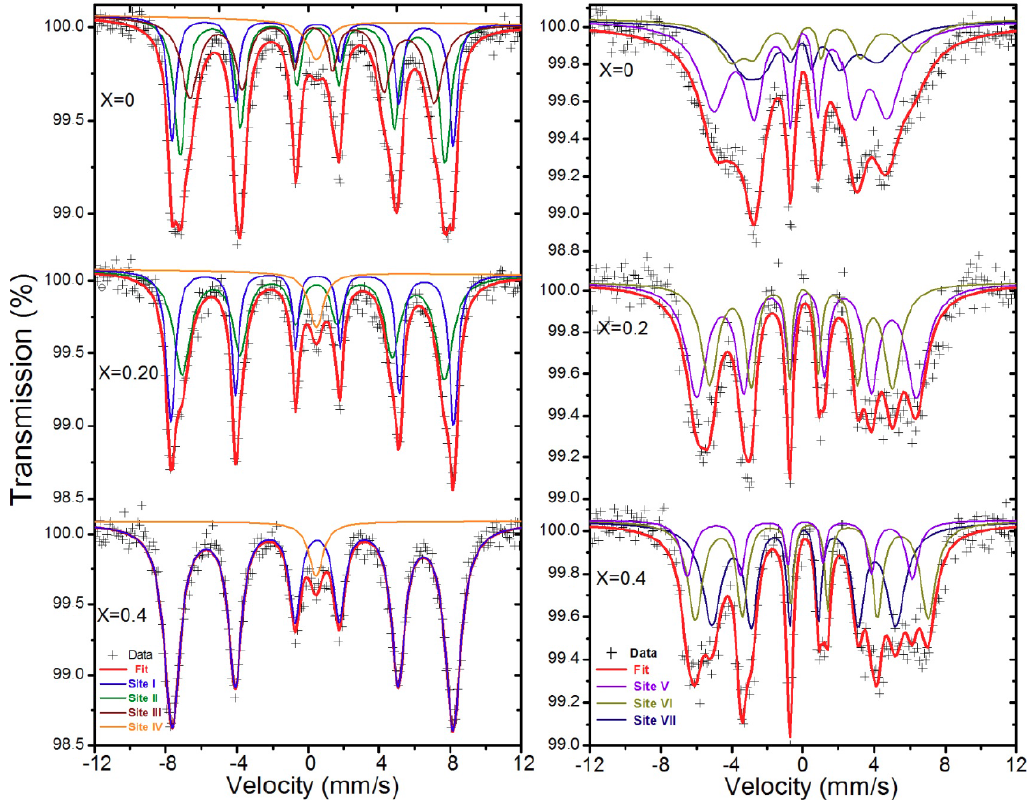
Figure 7. The Mössbauer spectra of selected N 2 - ( left ) and air-annealed ( right ) Sr 3 − x Pr x Fe 1.25 Ni 0.75 O 7 − δ phases recorded at 7 K.